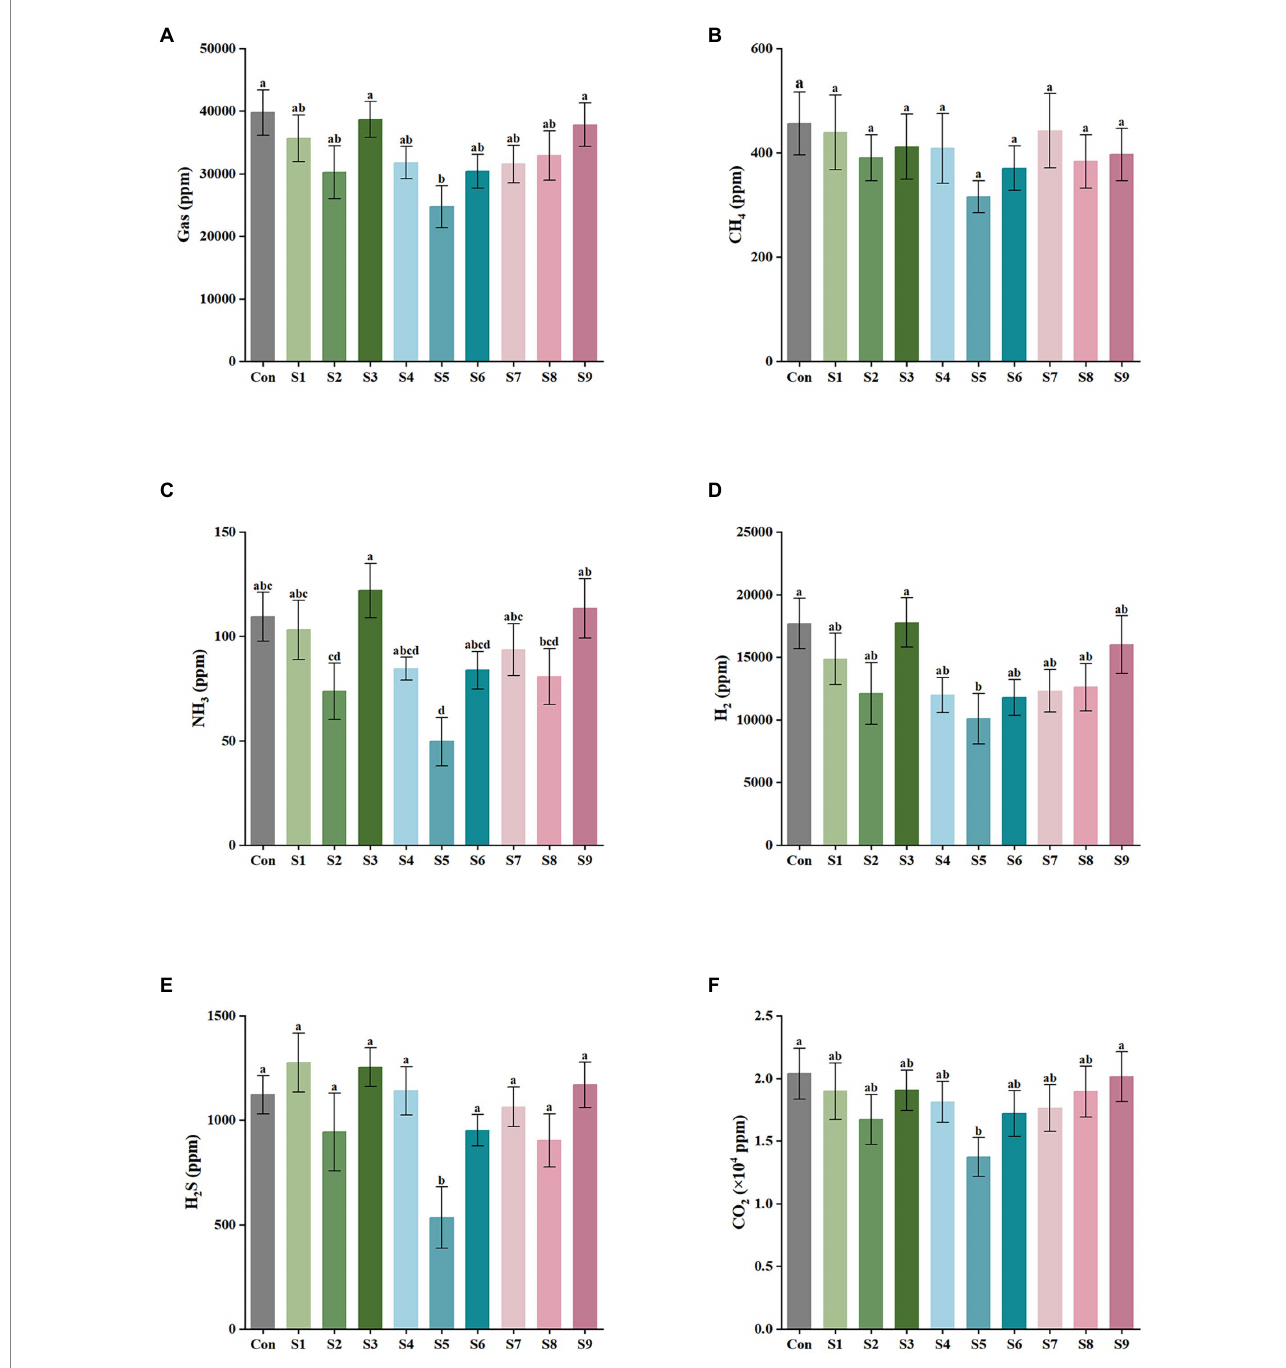
FIGURE 1 Gas composition and content of external fermentation of fecal microbiota under different substrate conditions. (A) The total amount of the five gases, (B) CH 4 , (C) NH 3 , (D) H 2 , (E) H 2 S, and (F) CO 2. Data are means ± SEM (10 independent experiments × 3 replication experiments). Different lowercase letters indicate significant differences ( p <